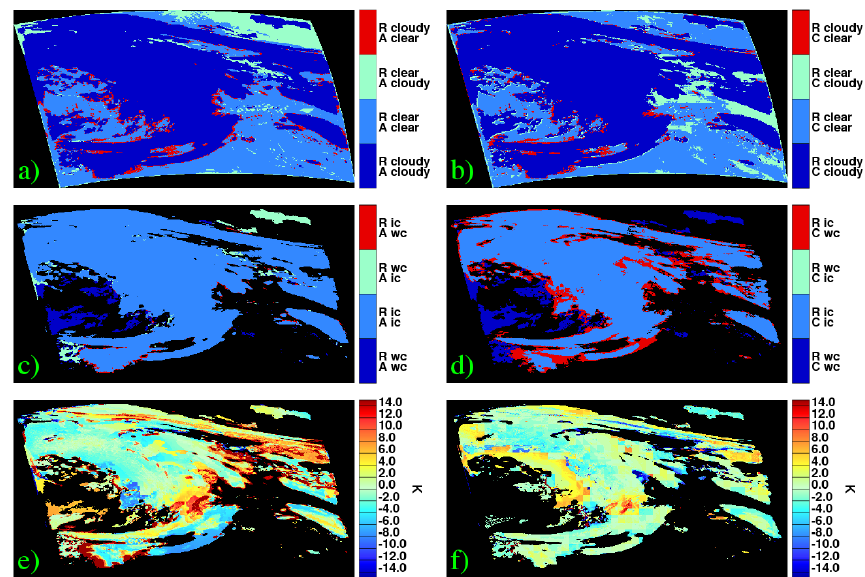
Fig. 7. Differences between retrieval results and real cloud properties. (a) Differences between real and APICS cloud mask. “R clear/cloudy” means that the pixel is really clear/cloudy, “A clear/cloudy” means that the pixel is cloudy/clear according to the APICS retrieval. (b) Differences between real and CMSAF cloud mask. “R clear/cloudy” means that the pixel is really clear/cloudy, “C clear/cloudy” means that the pixel is cloudy/clear according to the CMSAF retrieval. (c) Differences between real and APICS cloud top phase. “R wc/ic” means that the pixel contains a real water/ice cloud, “A wc/ic” means that the pixel contains a water/ice cloud according to APICS. (d) Differences between real and CMSAF cloud top phase. “R wc/ic” means that the pixel contains a real water/ice cloud, “C wc/ic” means that the pixel contains a water/ice cloud according to CMSAF. (e) Differences between retrieved and real cloud top temperatures for APICS. (f) Differences between retrieved and real cloud top temperatures for